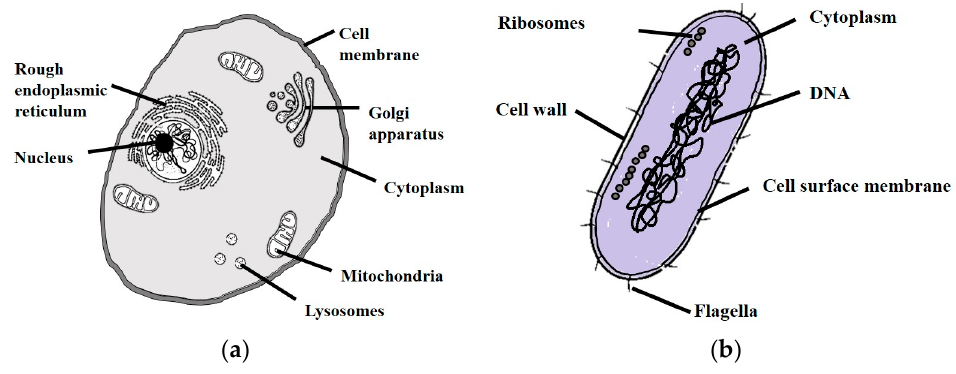
Figure 2. Anatomy of: ( a ) mammalian cell; and ( b ) bacteria.